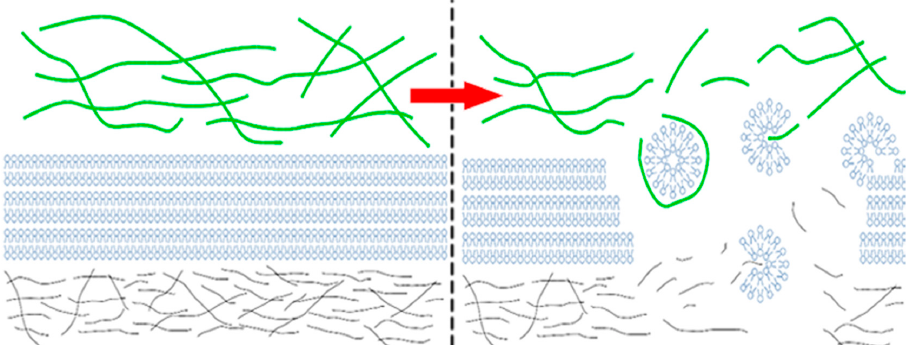
Figure 1. Graphical simplification of a synovial joint organ system. The left-hand side depicts normal synovial fluid conditions with longer hyaluronic acid (HA) chains and mature HA networks (green), phospholipid (PL) bilayers of the oligolamellar surface-active phospholipid layer (blue), and the superficial zone of articular cartilage (grey). The right-hand side depicts osteoarthritic synovial fluid conditions with correspondingly shorter HA chains, rudimentary HA networks, PL micelles, and a damaged superficial zone upon which the surface-active phospholipid layer cannot form.